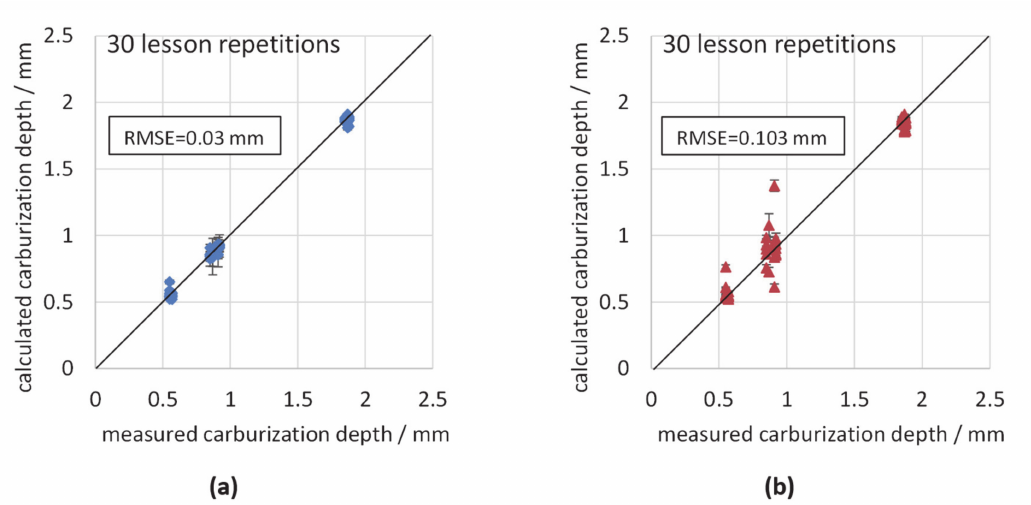
Figure 14. Correlation of micromagnetic determined and actual measured carburization depth after 30 repetitions of the training lesson for training ( a ) and test data set ( b